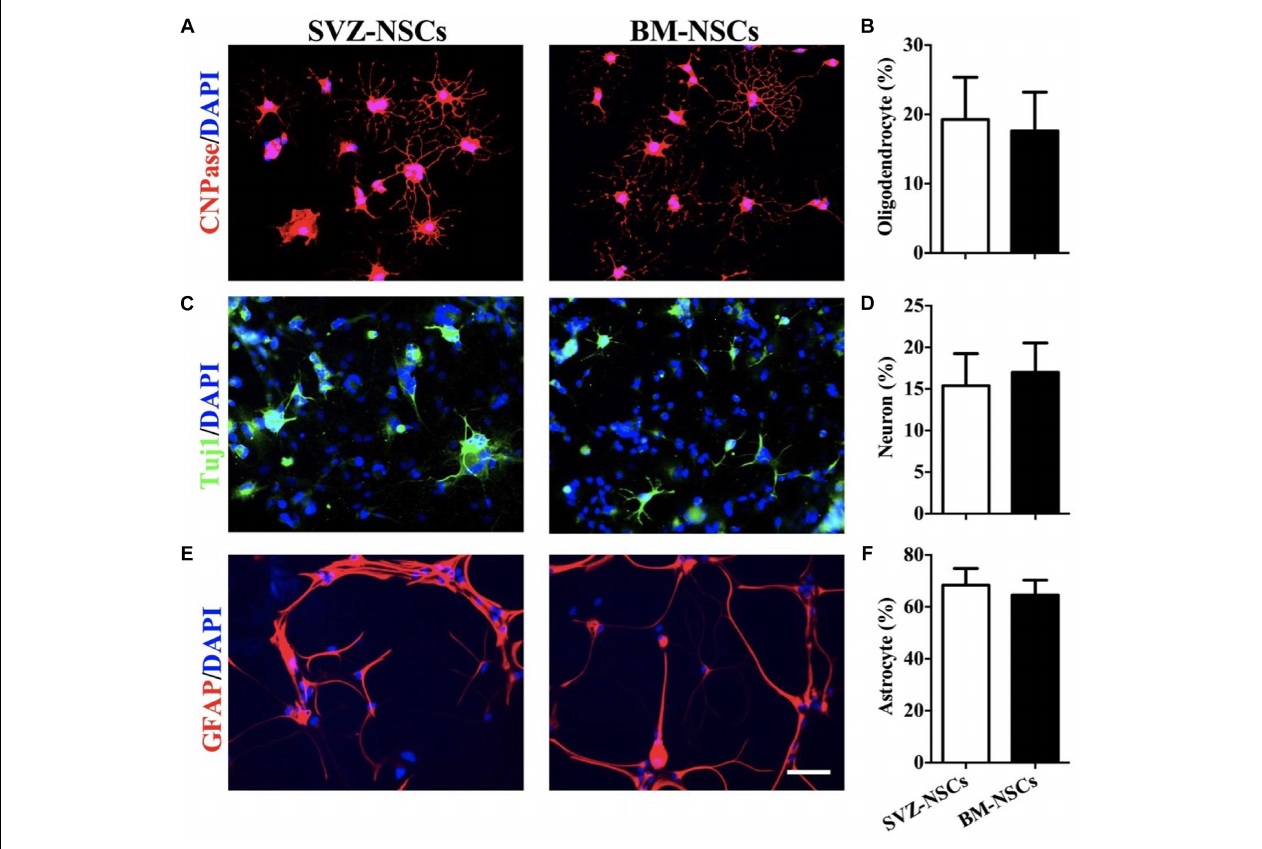
FIGURE 3 | BM-NSCs differentiation in vitro . Examples of NSCs that differentiated into (A) OLGs (CNPase + ), (C) neuron (Tuj1 + ), and (E) astrocytes (GFAP + ), after 1 week with specific differentiation media. Scale bar = 50 µ m. (B , D , F) Quantitative analysis of differentiated cells. Data are shown as mean values ± SD ( n = 5 each group) and are representative of three experiments. Significance difference was analyzed by Student’s t